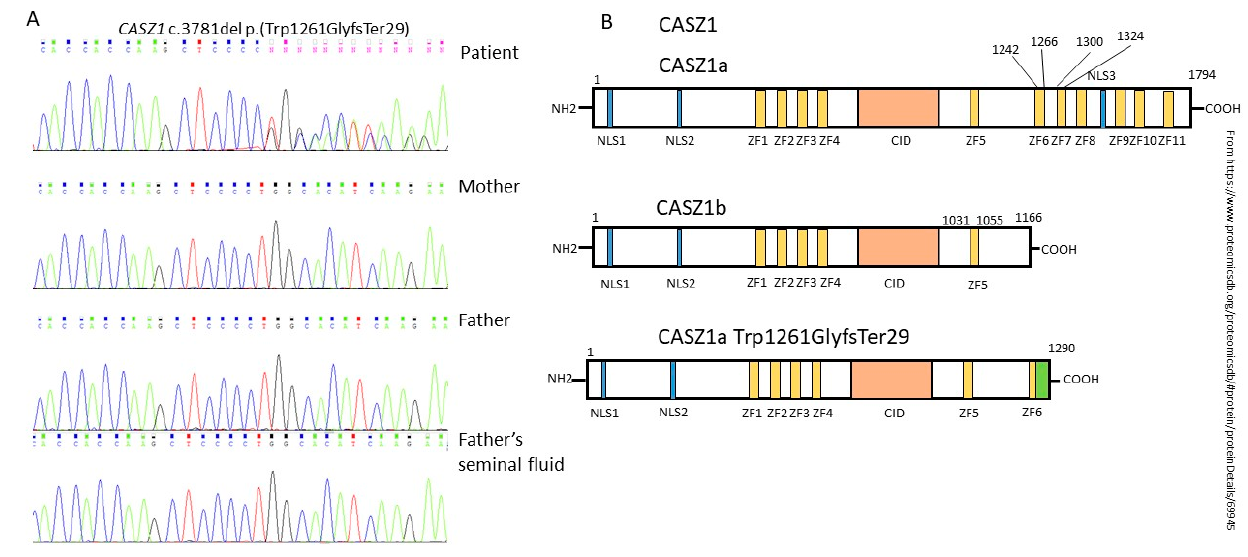
Figure 1. ( A ) Sanger sequence validation of proband and parents; ( B ) structure of the CASZ1 protein (isoforms CASZ1a, CASZ1b, and mutant